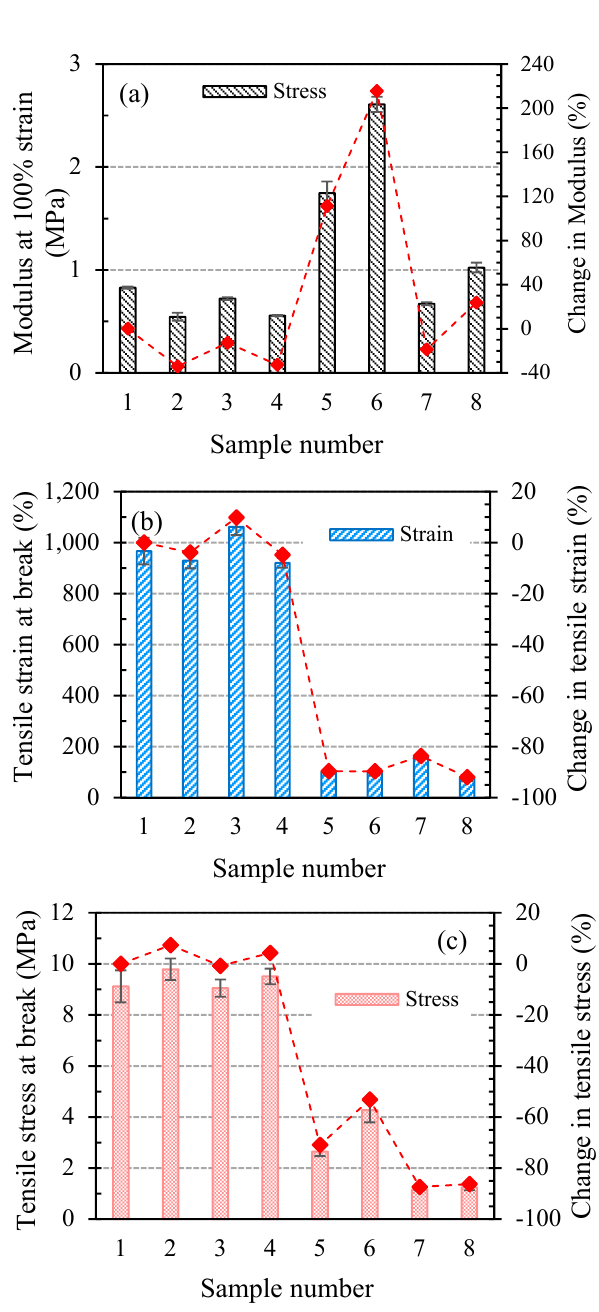
Figure 6. Tensile properties of SR samples, ( a ) modulus at 100% strain, ( b ) tensile strain at break, and ( c ) tensile stress at break.